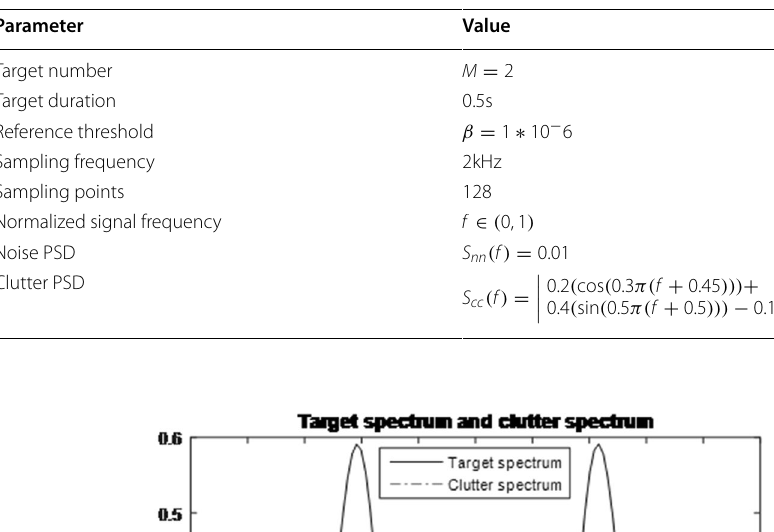
Table 1 Main simulation parameters